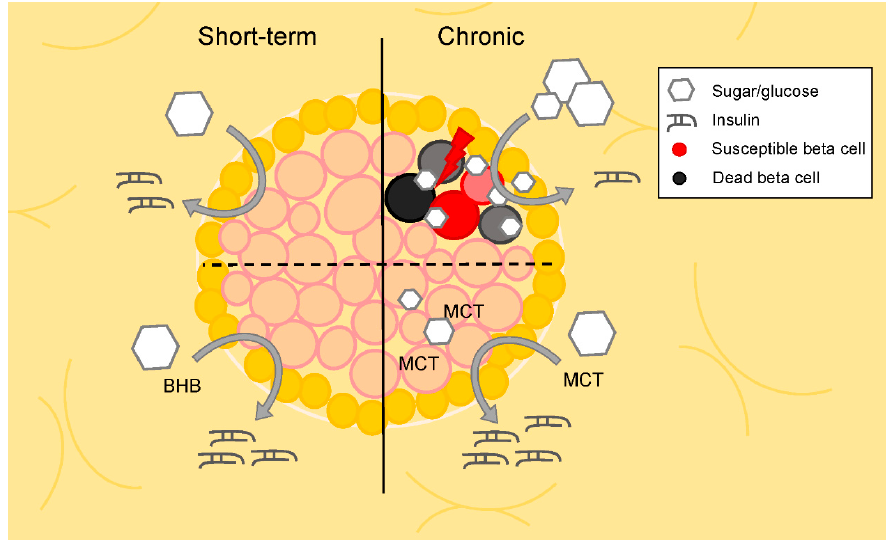
Figure 2. Short-term and chronic effects of metabolites on pancreatic beta cell insulin secretion. In vitro investigations in isolated islets reveal an additive e ff ect of BHB and glucose on insulin secretion, but no insulin secretion with BHB alone. While long-term treatment with high glucose can lead to reduced glucose-stimulated insulin secretion, some evidence suggests increased insulin secretion in response to high glucose following chronic (72 h) treatment with ketones and medium chain